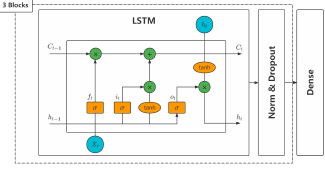
Figure 2. The structure of